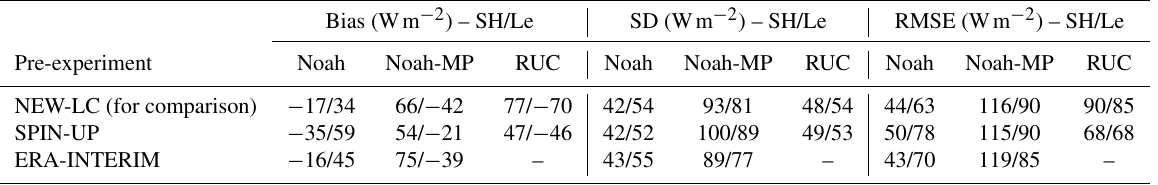
Table 4. Summary of the scores (Wm − 2 ) calculated in the whole evaluated area for each LSM (columns) configured for each pre-experiment (raws, SPIN-UP, and ERA-INTERIM). The scores of the NEW-LC experiments are included to quantify the impact of the change in the initial conditions. The first value refers to the sensible heat flux (SH) and the second one to the latent heat flux (Le). Some experiments were not possible (–) for some LSMs. The scores used are the bias (random error), standard deviation (SD) (systematic error), and the root mean square error